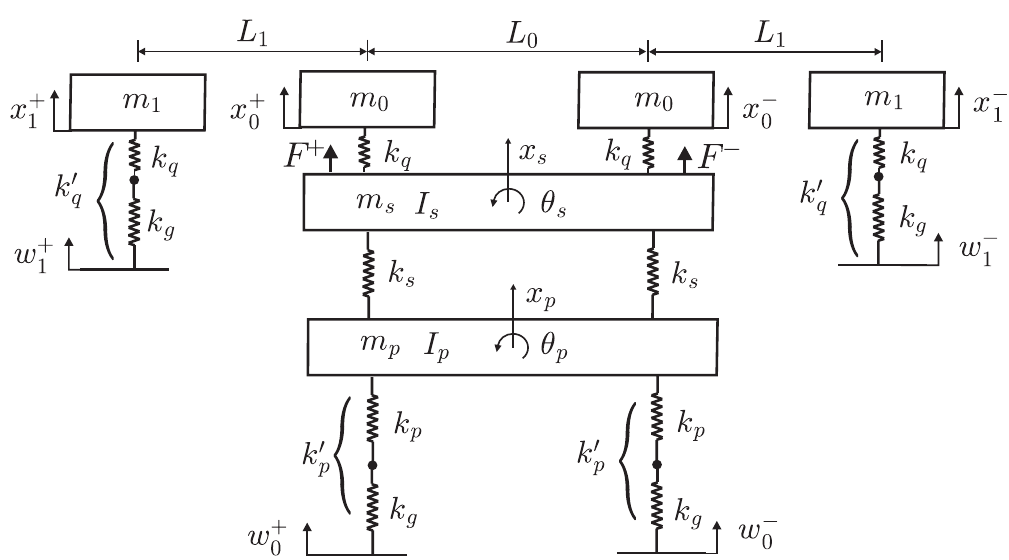
FIG. 2. Lumped mass model of the ILC final focus with the SiD